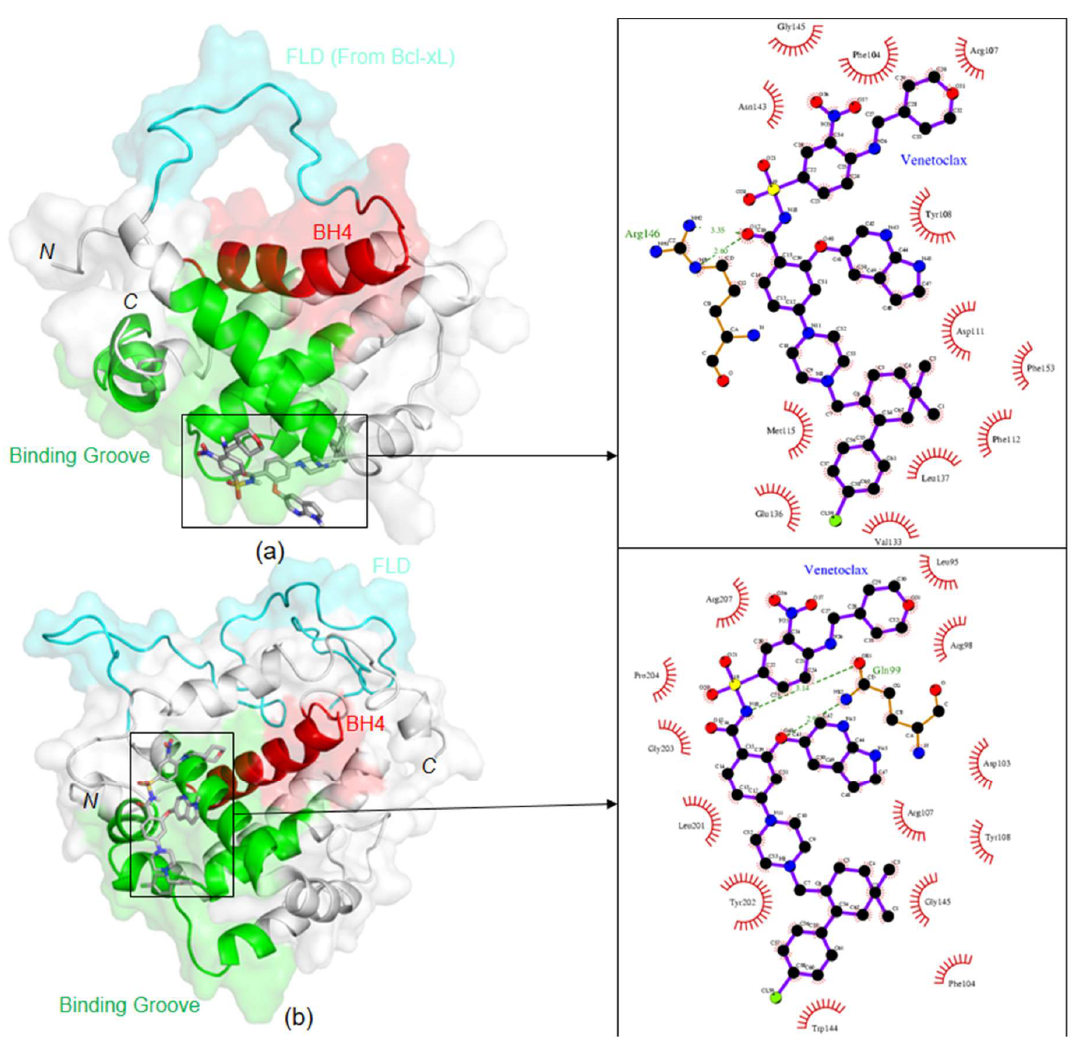
Figure 2. Docking orientation of venetoclax in ( a ) chimeric and ( b ) physiological Bcl-2 forms, and schematic representation of corresponding protein-ligand interactions, on the right. Color codes: FLD in cyan; binding groove formed by BH1, BH2 and BH3 domains in green; BH4 domain in red.